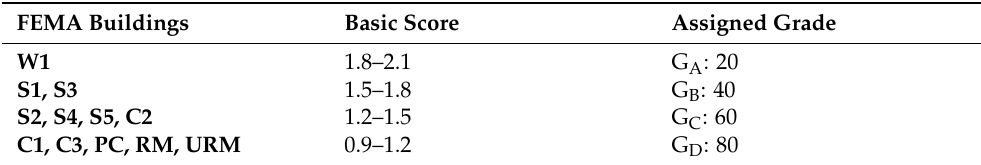
Table 7. Degree of vulnerability by FEMA building